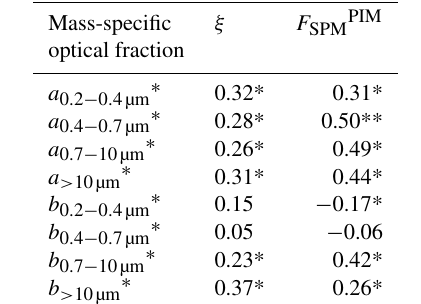
Table 2. Particle size and chemical composition effects on mass- specific optical coefficients. Spearman rank correlations for a i ∗ and b i ∗ are computed at a wavelength of 440 and 550nm,